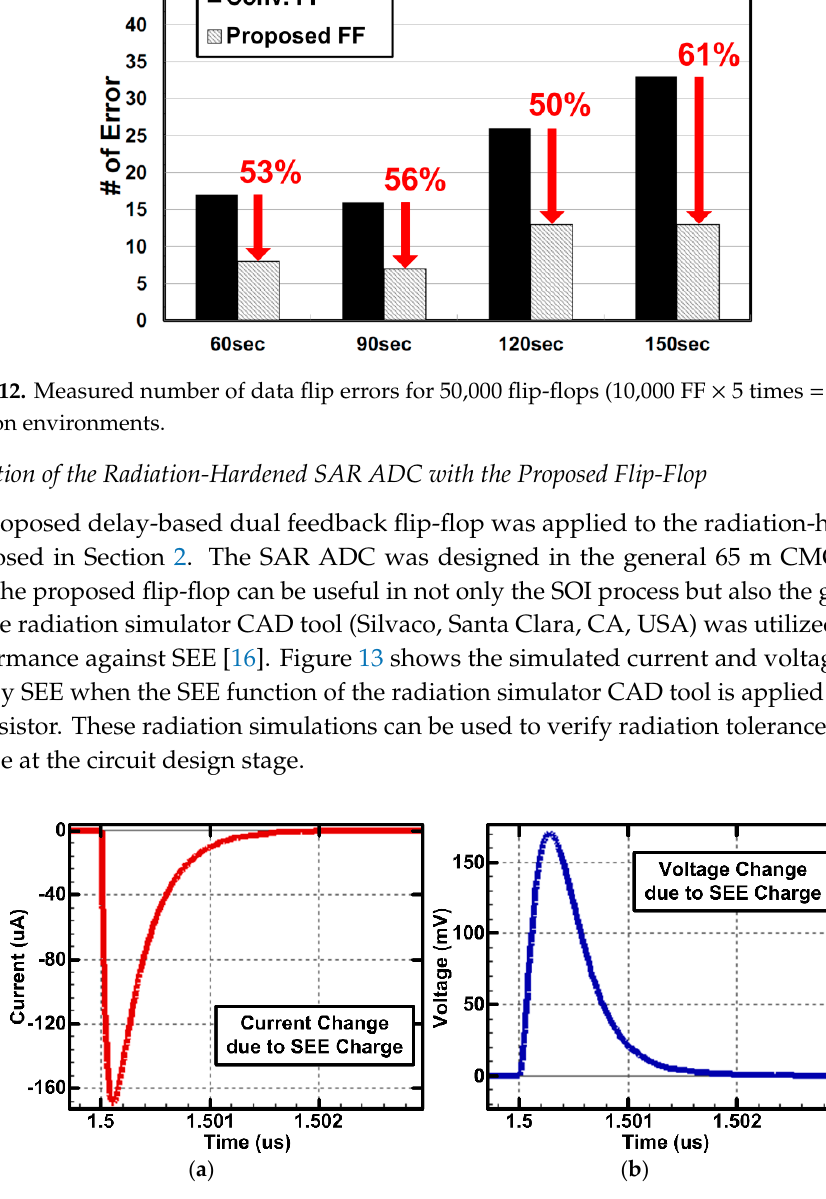
Figure 13. Simulated waveforms of the ( a ) current and ( b ) voltage changes due to SEE.